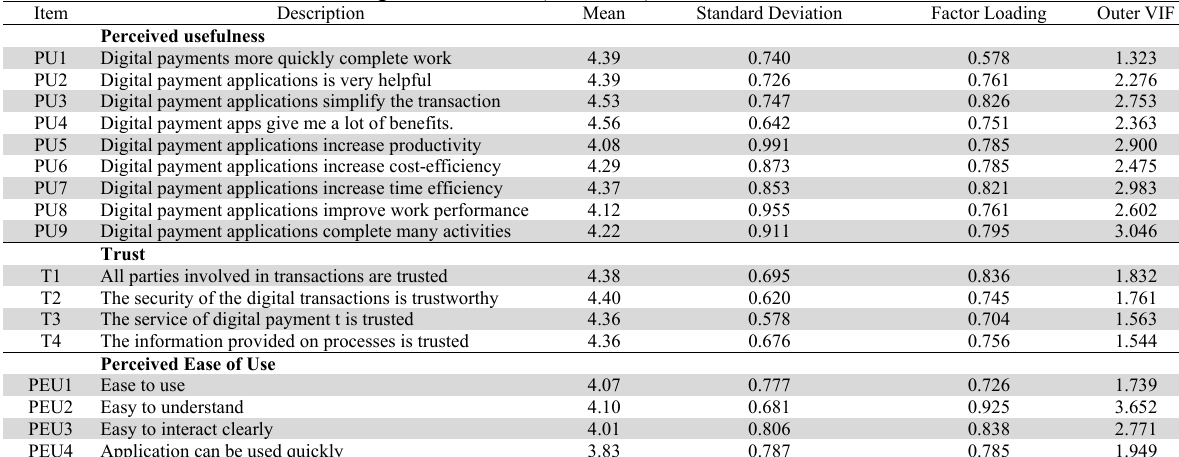
Mean, Standard deviation, factor loading, and outer VIF (Continued)